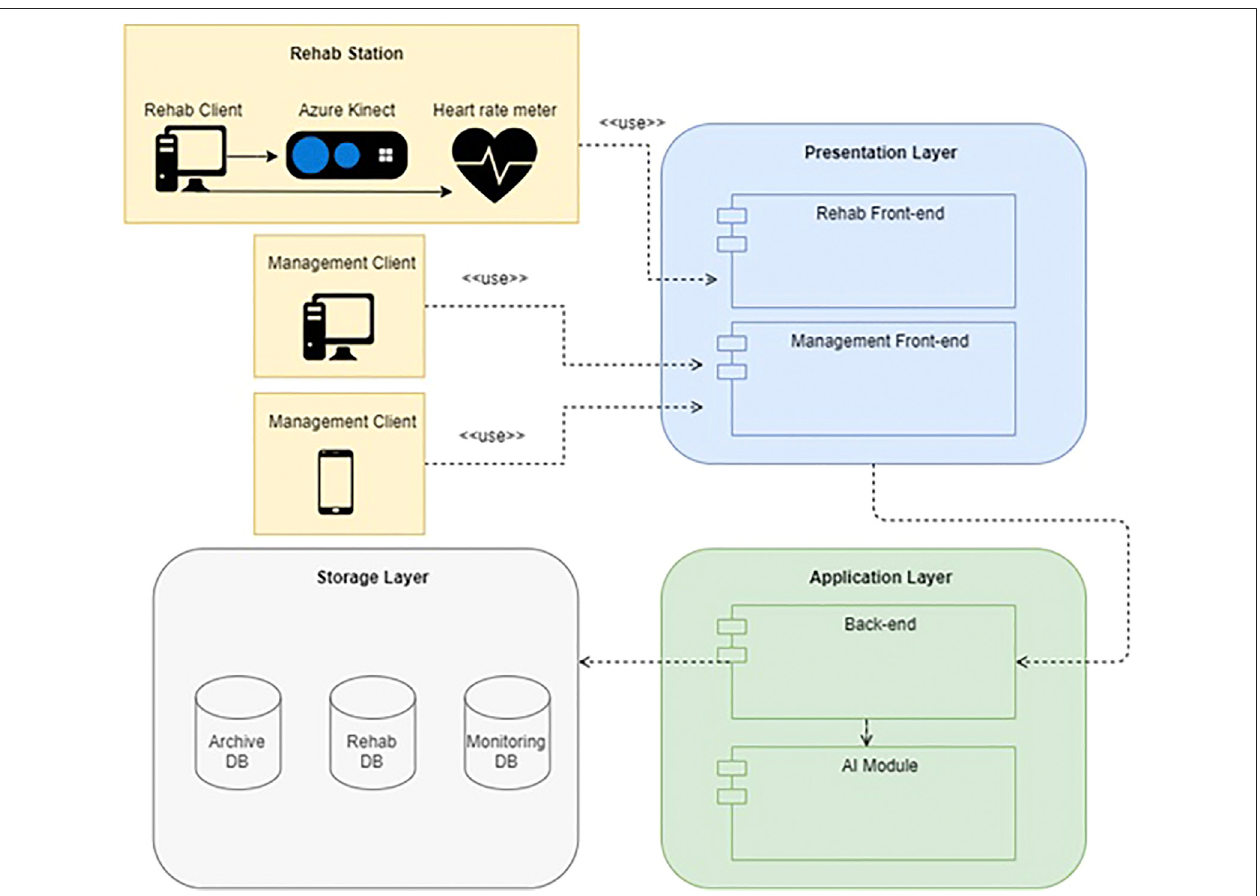
FIGURE 2 | Three-tier architecture in the 2Vita-B Physical